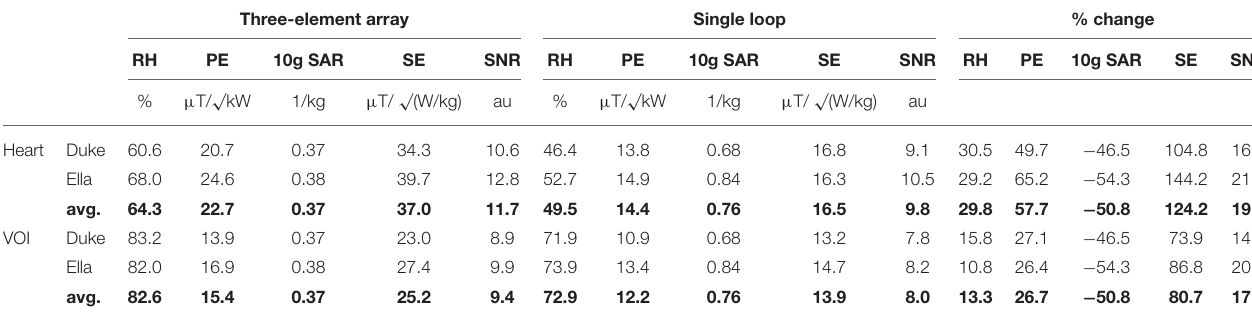
TABLE 3 | Simulation comparison of 3-element array vs. single loop coil.